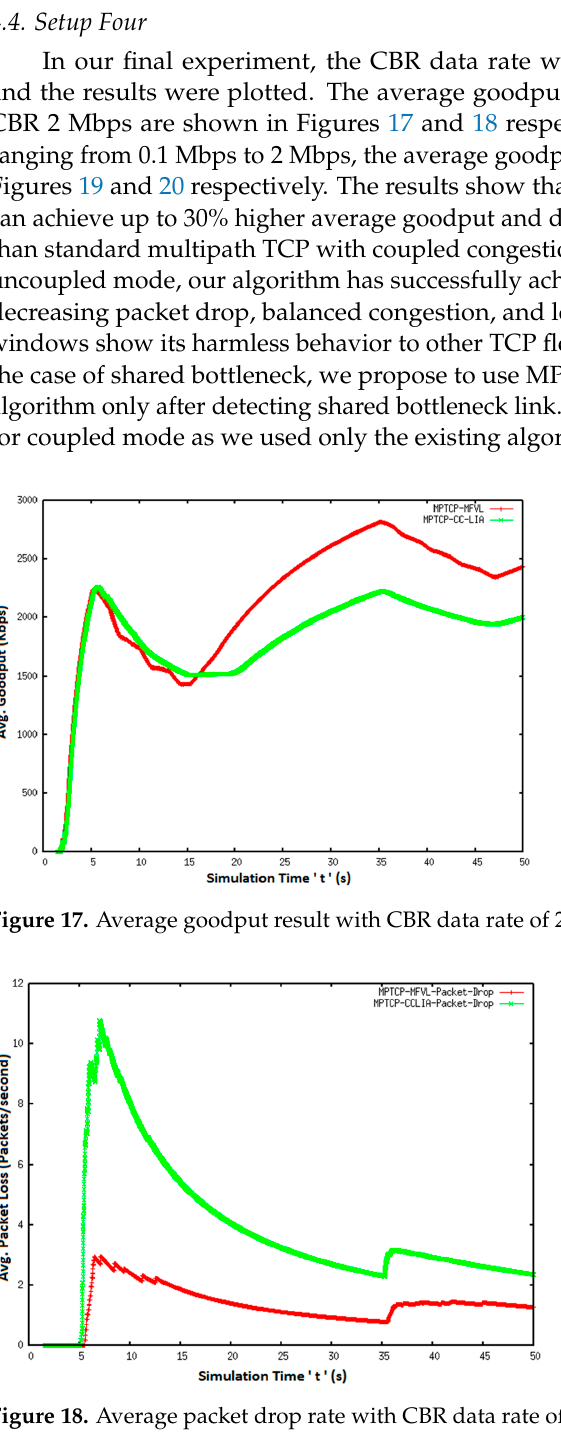
Figure 19. Average goodput result with CBR data rate 0.1 to 2 Mbps.